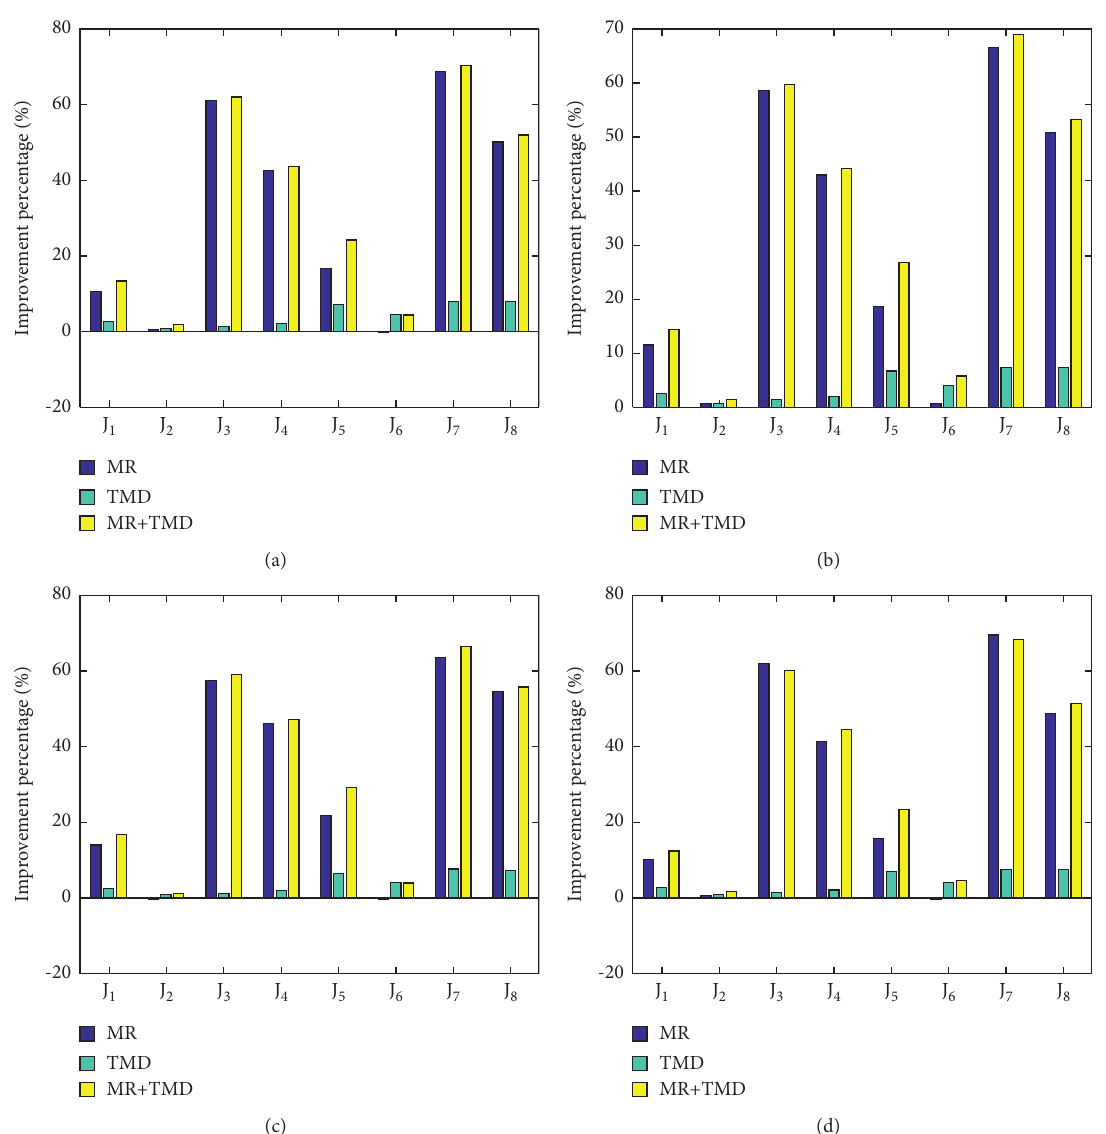
Figure 6: Average percentage of improvement in performance criteria: (a) regular structure subjected to near-field earthquakes, (b) stiffness irregularity in the 1st–5th stories of structure subjected to near-field earthquakes, (c) stiffness irregularity in the 1st story of structure subjected to near-field earthquakes, (d) stiffness irregularity in the 5th story of structure subjected to near-field